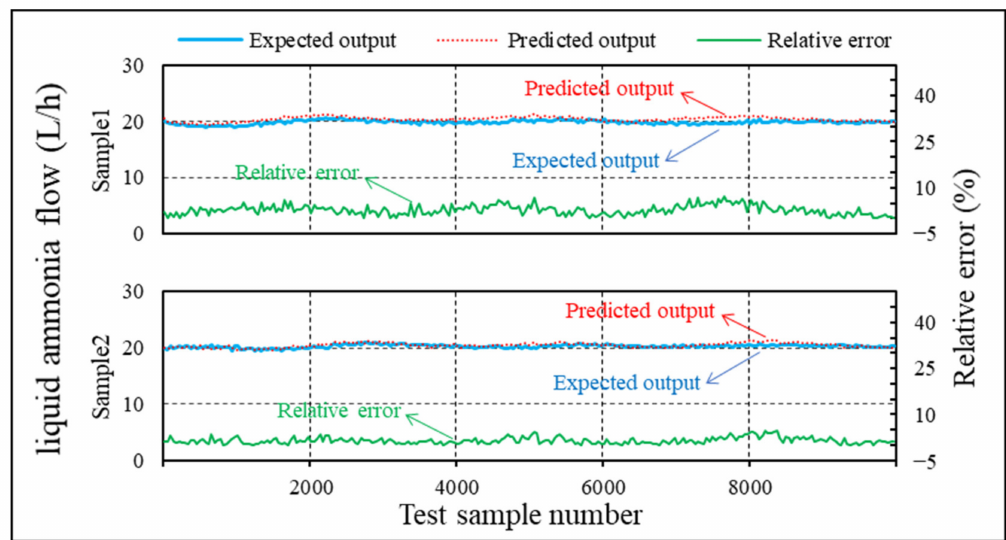
Figure 12. Predicted liquid ammonia flow by Elman.